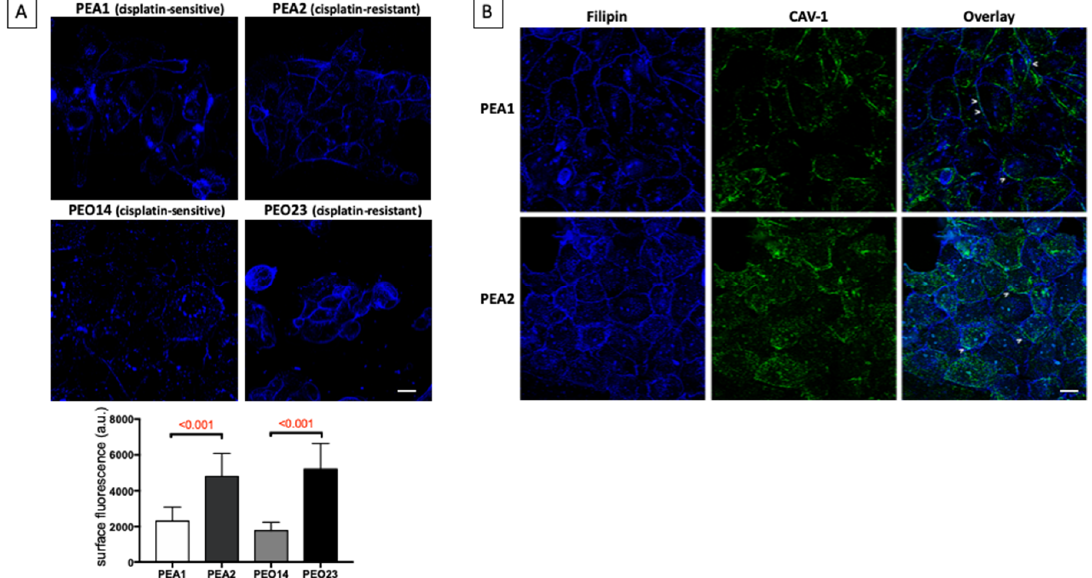
Figure 3. Transition to chemoresistance correlates with an increase of cholesterol at the cell surface. ( a ) Microscopy analysis of unesterified cholesterol through the visualization of filipin fluorescence in the two matched pair of cisplatin-sensitive/resistant cell lines PEA1/PEA2 and PEO14/PEO23. Maximum projection of Z-slices is shown. Scale bar = 20 μm. The bar graph (lower panel) shows the mean fluorescence intensity (arbitrary unit, a.u.) of filipin at the cell surface. Data are expressed as mean ± Standard deviation (SD) ( n > 30). Numbers above bars indicate the statistical significance ( p -value) based on Student’s t-test. ( b ) Representative images of double staining, in PEA1 and PEA2 cells, of unesterified cholesterol (Filipin) with Caveolin-1 (CAV-1). Overlay regions between filipin and CAV-1 stainings are indicated with arrowheads. Scale bar = 20 μm.